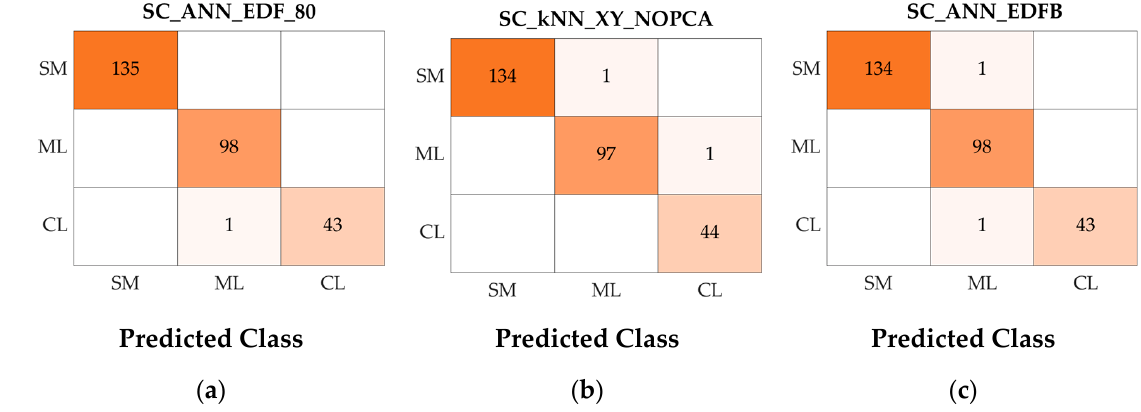
Figure 9. Confusion matrix of predicted soil classi fi cation from ( a ) SC_ANN_EDF_80, ( b ) SC_ANN_XY_90, and ( c ) SC_ANN_EDFB model.